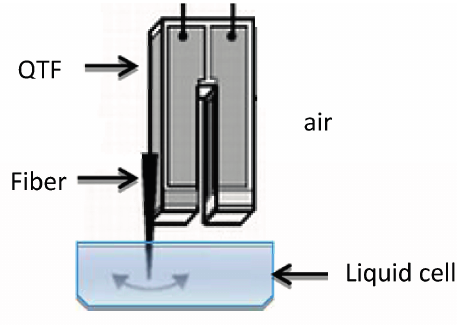
Figure 1. Schematic of the QTF configuration working in shear mode in a liquid